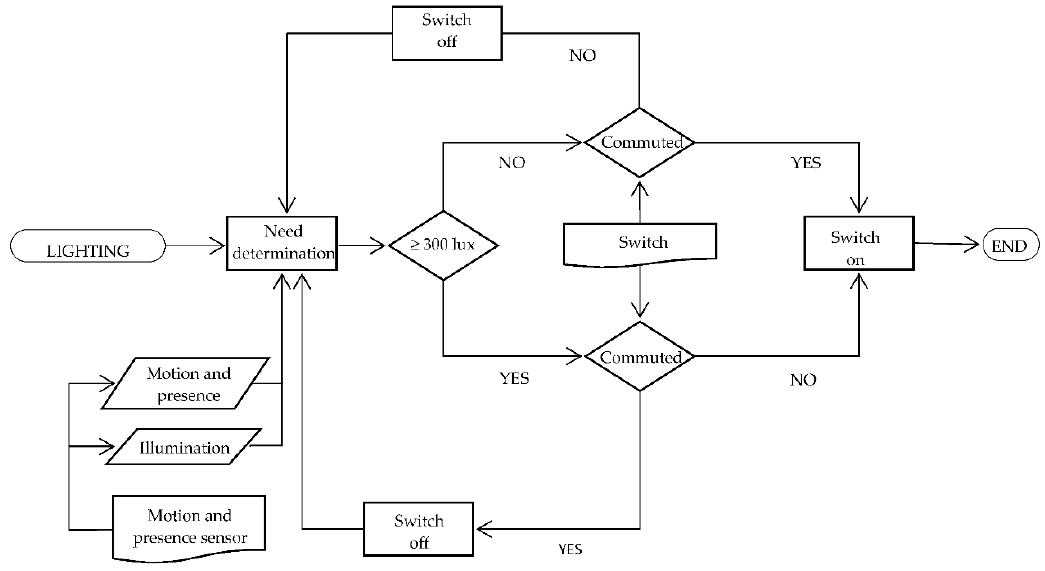
Figure 2. Lighting functioning flow chart.